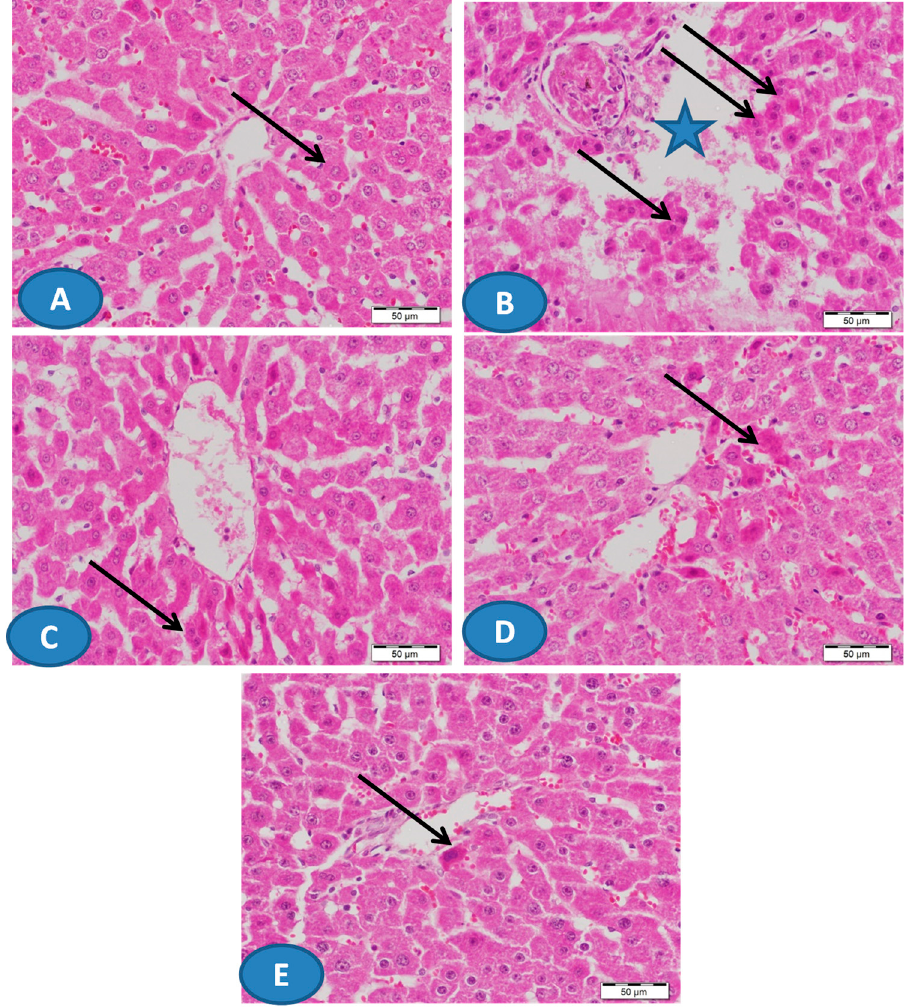
Figure 2. Photomicrographs of hematoxylin and eosin (H&E)-stained sections from liver of ( A ) control rats showing normal hepatic architecture with normal hepatocytes (arrow) and blood sinusoids, ( B ) Pb(II)-intoxicated rats showing focal areas of massive hepatic degeneration (star) and many degenerated hepatocytes (arrows), and ( C – E ) Pb(II)-administered rats treated with CUR ( C ) and AA ( D ) showing improvement of the hepatic architecture with degenerated hepatocytes (arrows), and CUR / AA ( E ) showing apparently normal hepatic architecture with very few degenerated hepatocytes (arrow). (X400, Scale bare 50 μ m).